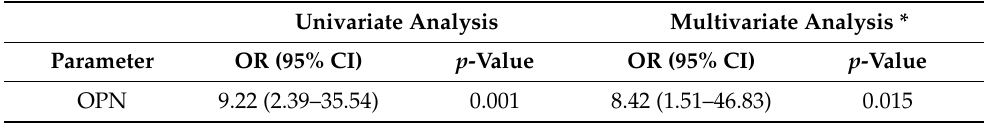
Table 3. Logistic regression of osteopontin (OPN) and coronary artery disease (CAD) in patients with low number of risk factors (RFs). Univariate Analysis